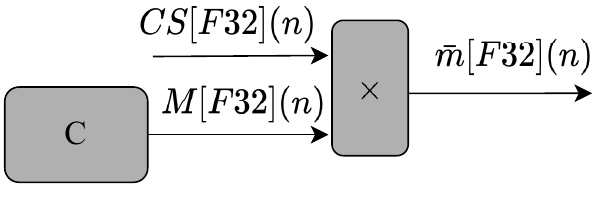
Figure 9. Block diagram representing the circuits for generating the mean values ¯ t [ F 32 ]( n ) and ¯ υ [ F 32 ]( n ) used as inputs of the circuits shown in Figures 6 and 7,